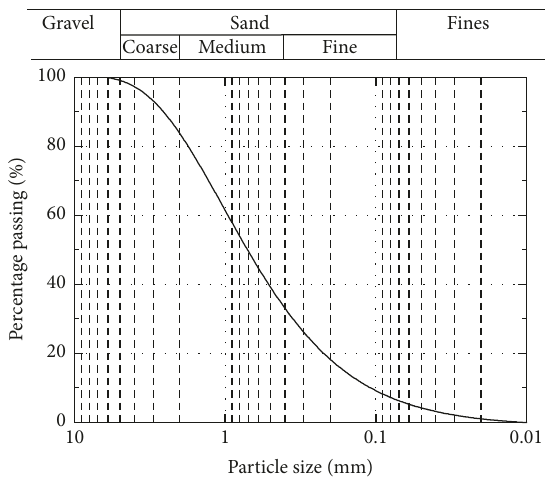
Figure 3: Grain size distributions of the ISO standard sand.